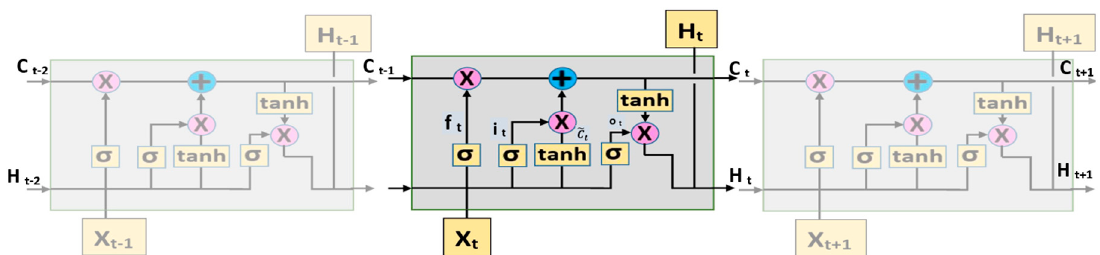
Figure 4. Working principle of LSTM architecture.